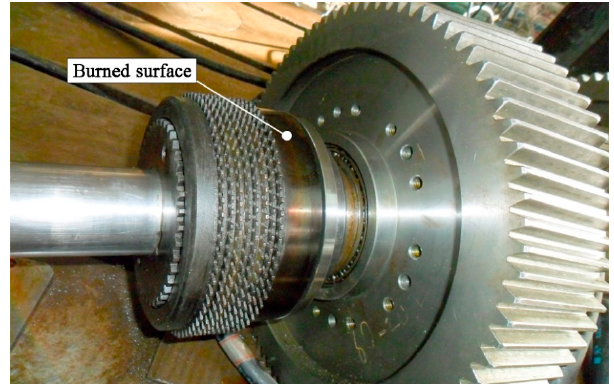
Figure 12. Clutch damaged due to failure mode T 2 .